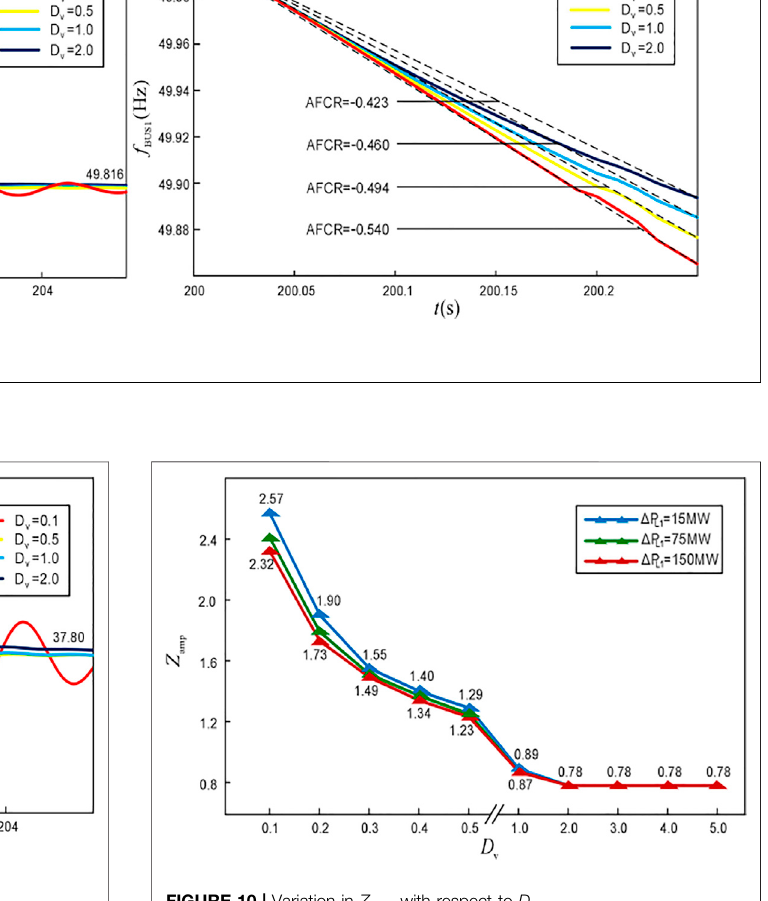
FIGURE 10 | Variation in Z amp with respect to D v